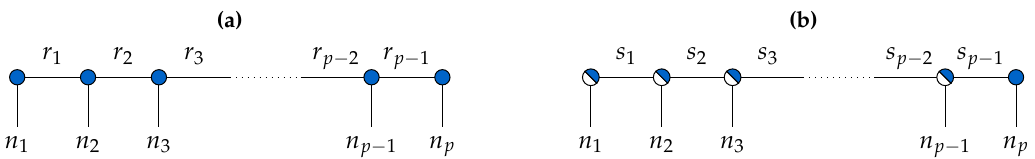
Figure 2. Graphical representation of tensor trains: ( a ) A core is depicted by a circle with different arms indicating the modes of the tensor and the rank indices. The first and the last tensor train (TT) core are regarded as matrices due to the fact that r 0 = r p = 1. ( b ) Left-orthonormalized tensor train obtained by, e.g., sequential singular value decompositions (SVDs). Note that the TT ranks may change due to orthonormalization, e.g., when using (reduced/truncated)